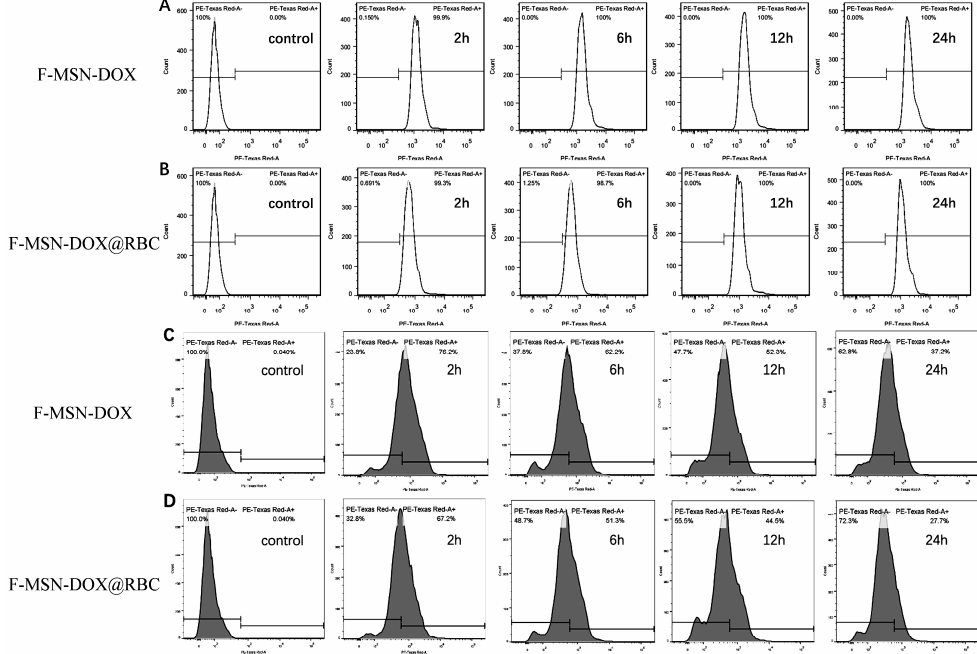
Figure 4. Phagocytosis of nanoparticles. ( A ) F-MSN-DOX and ( B ) F-MSN-DOX@RBC by RM-1 assessed with flow cytometry; ( C ) F-MSN-DOX and ( D ) F-MSN-DOX@RBC assessed by macrophages with flow cytometry.